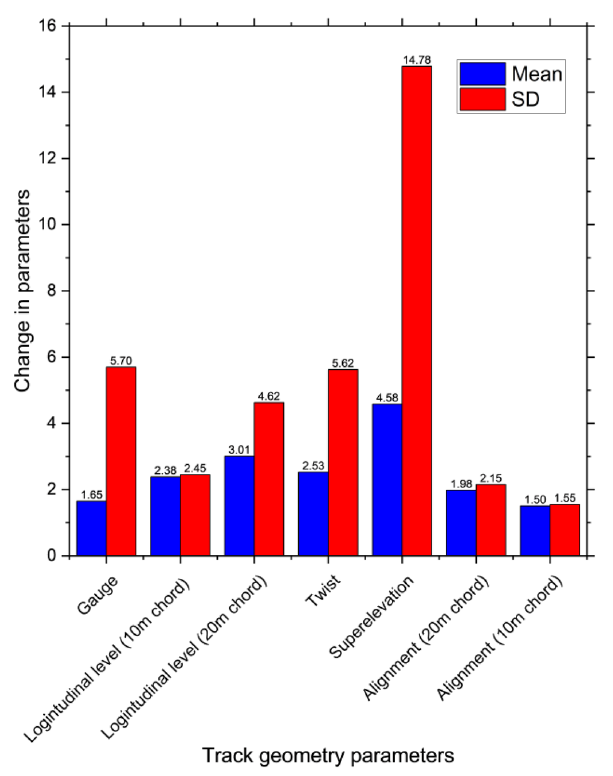
Figure 4. Track geometry improvement when tamping is